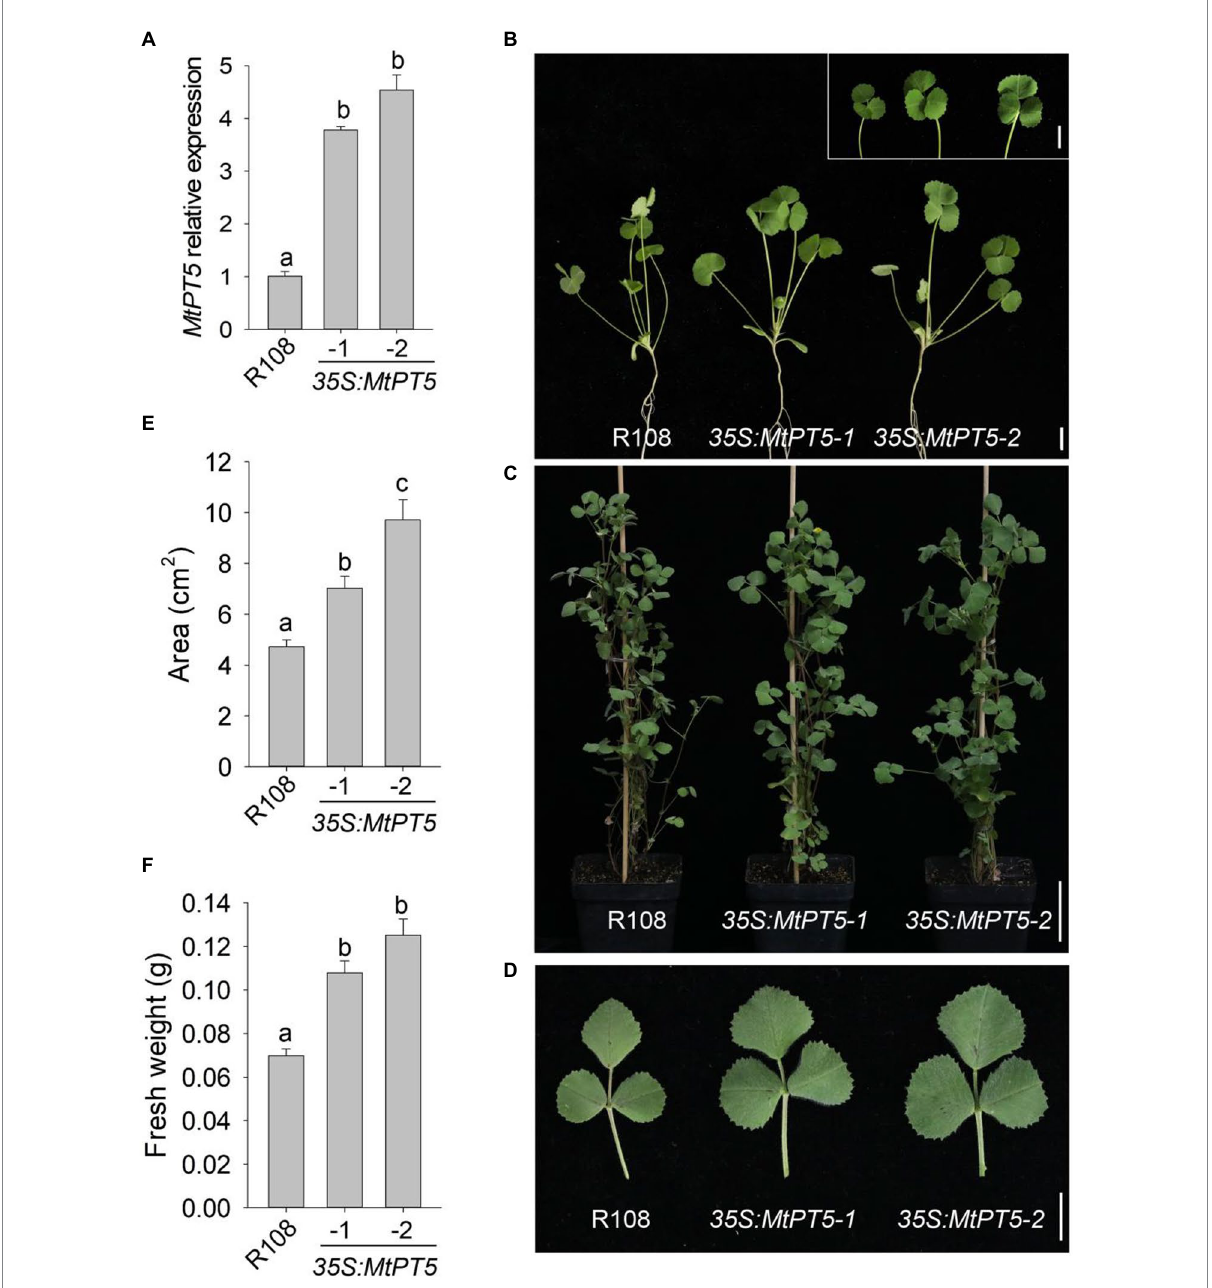
FIGURE 4 Overexpression of MtPT5 promotes leaves growth of M. truncatula. (A) qRT-PCR analysis of MtPT5 in wild-type M. truncatula (R108) and MtPT5 -overexpressing plants ( 35S:MtPT5-1 and 35S:MtPT5-2 ). Data represent mean ± SE ( n = 3). Different letters indicate significant difference at p < 0.05 (One-way ANOVA, Tukey test). (B–D) Phenotypic comparation of wild type (R108) and MtPT5- overexpressing plants. (B) Four-day-old seedlings were transferred to 1/2 Hoagland and grown for 20 days. Inset is leaves detached from the indicated plants. Bars = 1 cm. (C) Plants grown in soil for 3 months. Bar = 5 cm. (D) Top leaflets detached from (C) . Bar = 1 cm. (E) Quantification of leaf areas. The fourth leaf of wild type (R108) and MtPT5- overexpressing plants shown in (B) were taken for quantification. Data represent mean ± SE ( n = 8). Different letters indicate significant difference at p < 0.05 (One-way ANOVA, Tukey test). (F) Fresh weight of four expanded leaves detached from (B). Data represent mean ± SE ( n = 8). Different letters indicate significant difference at p < 0.05 (One-way ANOVA, Tukey